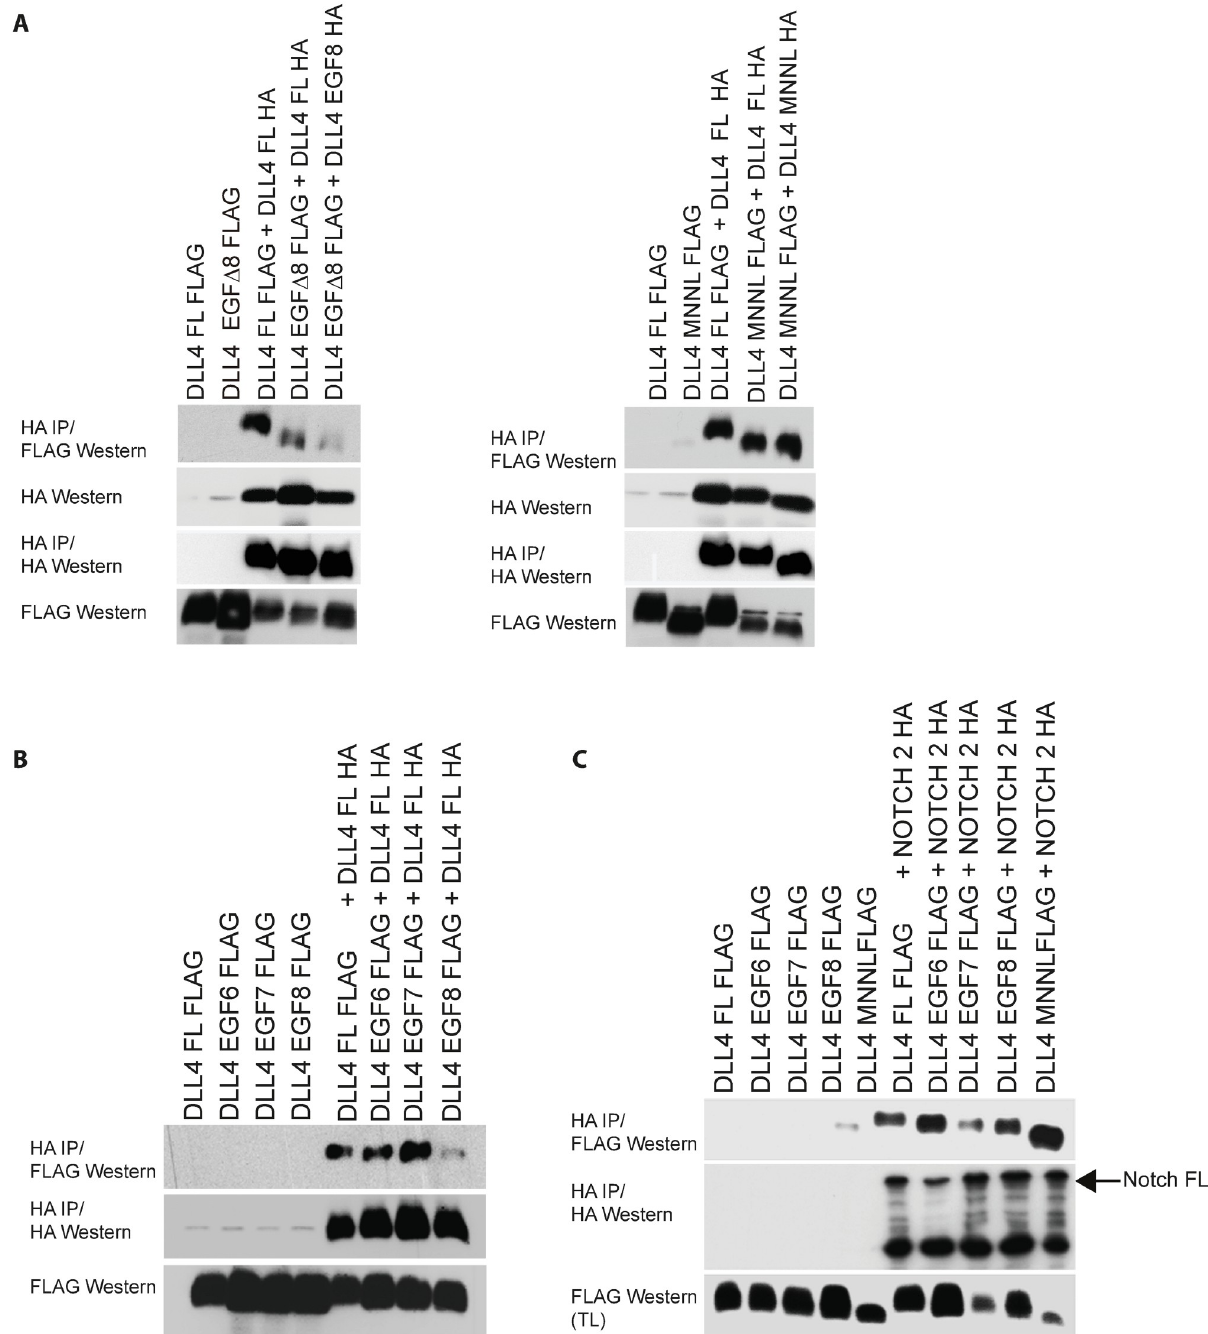
Fig 3. (A-C) The indicated constructs were transfected into tissue-culture cells. DLL4 EGF6, EFG7, EGF8, MNNL each have deletions of the named domain. Complexes were resolved by immunoprecipitation and visualized by Western blotting with the highlighted antibodies.